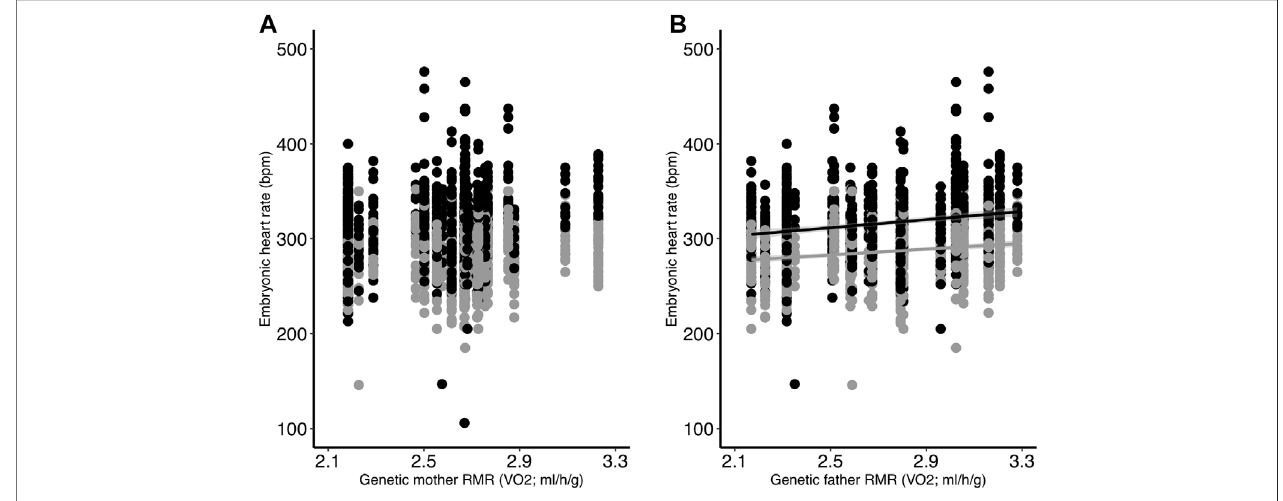
FIGURE 2 | The relationships between egg heart rate (bpm) and (A) genetic mother RMR and (B) genetic father RMR. Eggs were incubated at two different temperatures (black = control; gray = low). All egg heart rate measurements are shown. Regression lines are included only for signi fi cant relationships.